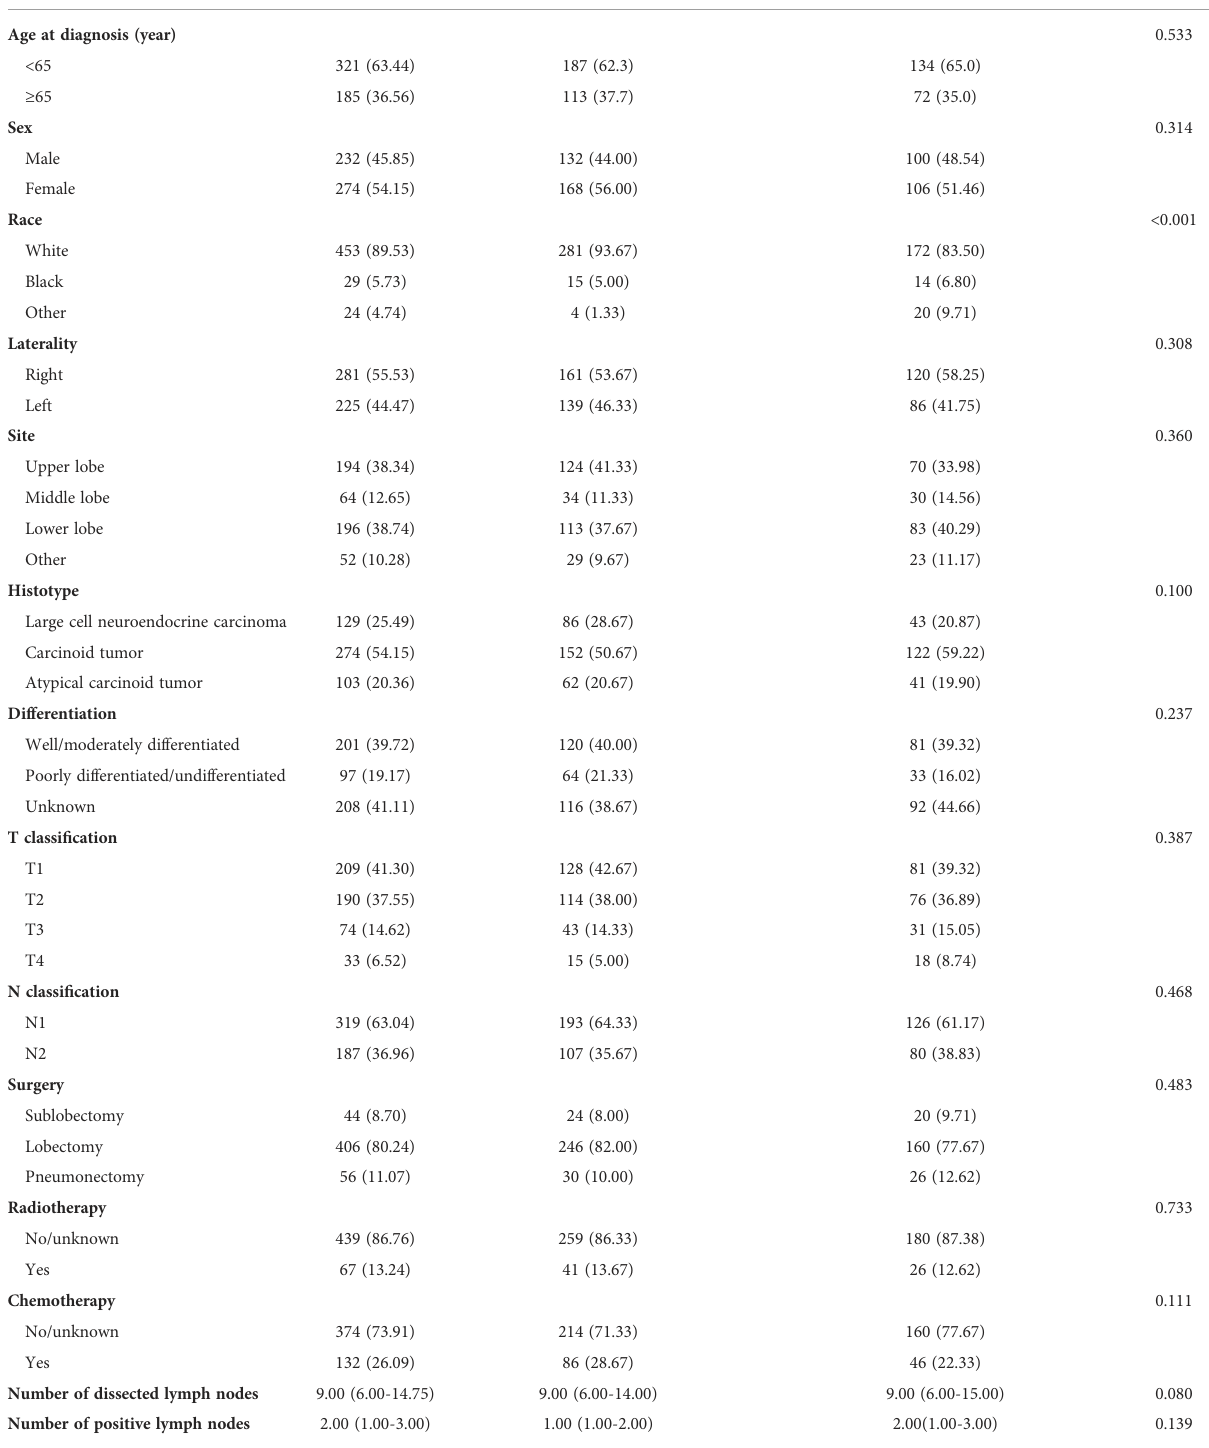
TABLE 1 Baseline characteristics of derivation dataset and external validation